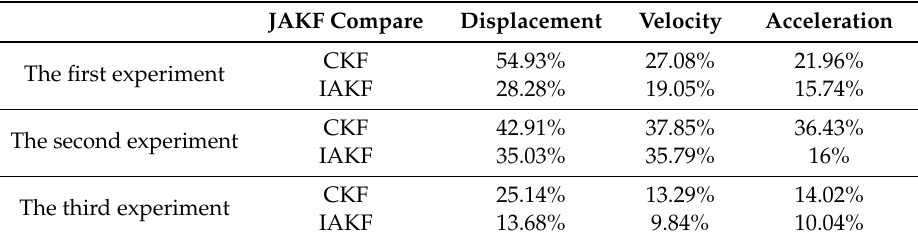
Table 6. Ratio of accuracy improvement of JAKF in the three